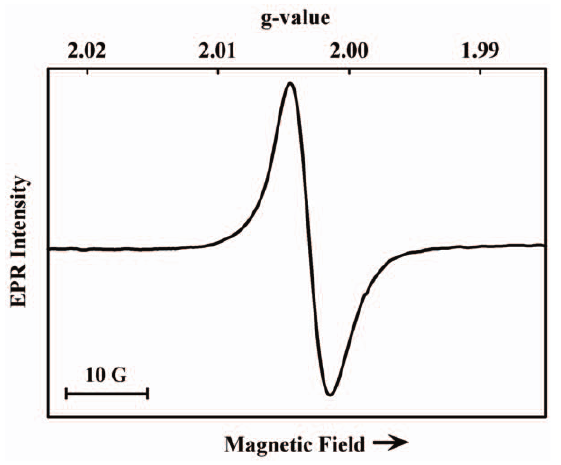
Figure 2. EPR spectrum (77 K) of melanized C.neoformans cells (1.9 6 10 9 cells/mL).